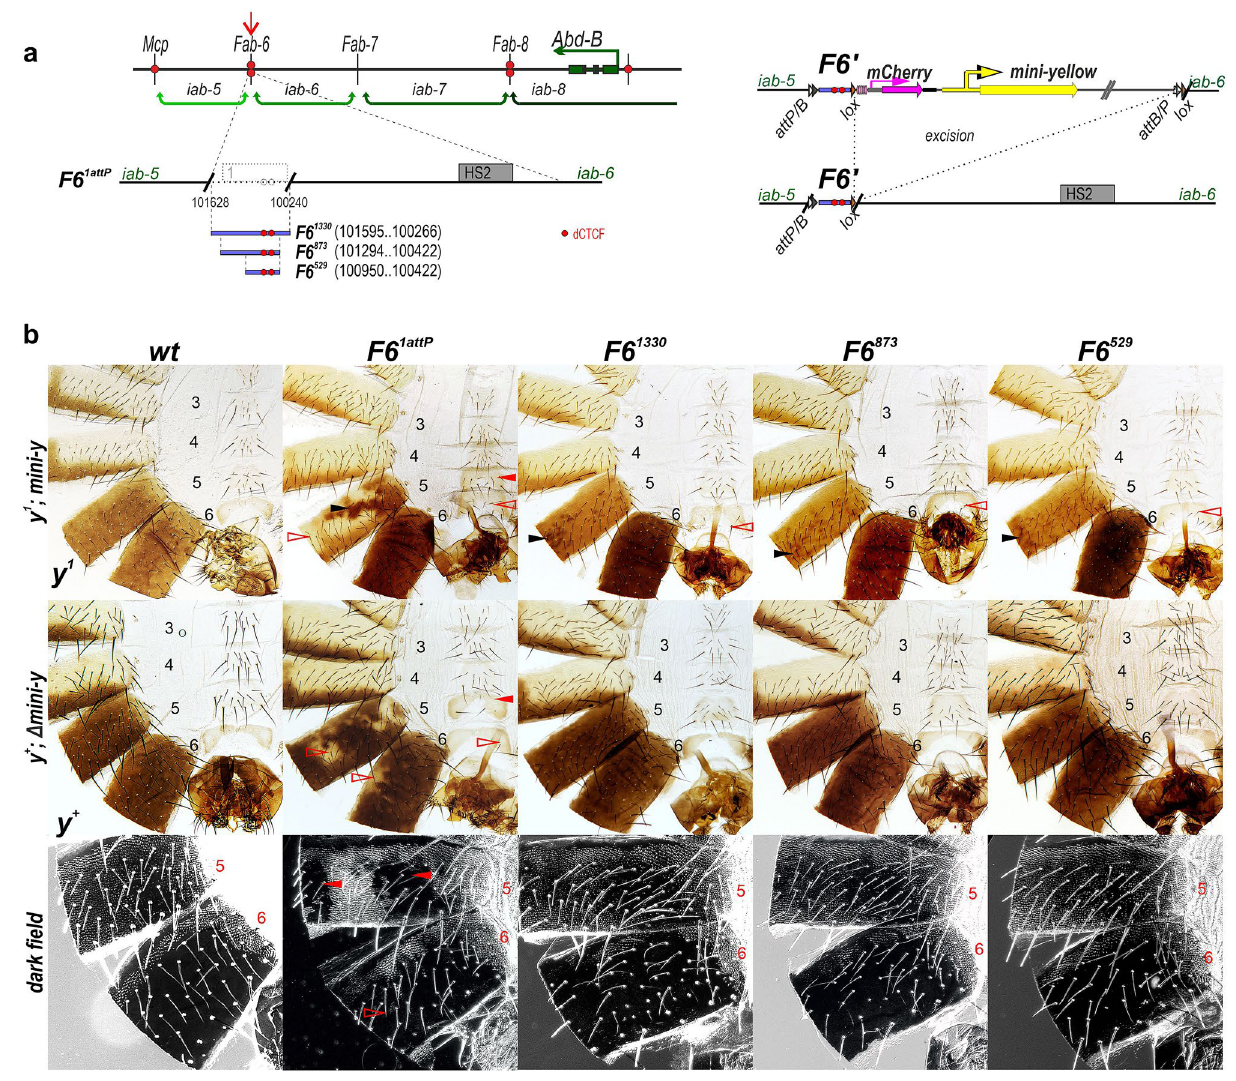
Figure 2. Mapping minimal sequences in HS1 Fab-6 required for boundary function. ( a ) Schematic diagram of the Fab-6 replacements . The coordinates of the Fab-6 fragments ( F6 ′ ) are according to the BX-C sequence 61 . On the right side: scheme of the replacements after integration in F6 1attP platform. The mCherry and mini-y genes are indicated by magenta and yellow arrows respectively. ( b ) Morphology of the male abdominal segments (numbered) in F6 1attP , F6 1330 , F6 873 and F6 529 . The filled red arrowheads show morphological features indicative of GOF transformations. The empty red arrowheads show LOF transformations. Black arrowheads indicate pigmented spots that are the result of ectopic activation of the mini-y reporter. All other designations are the same as described in Fig.